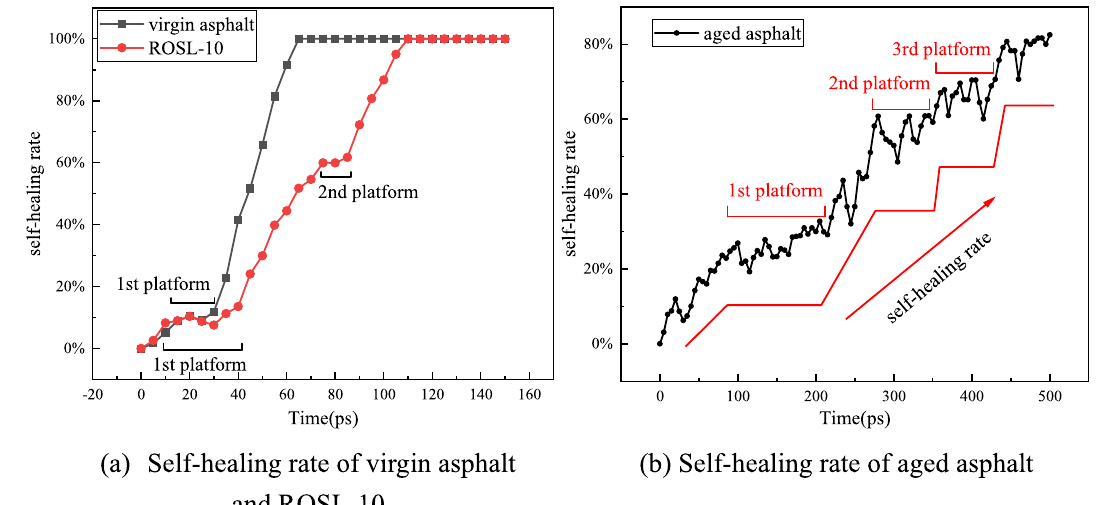
Figure 10. Self-healing rate of virgin asphalt, aged asphalt and